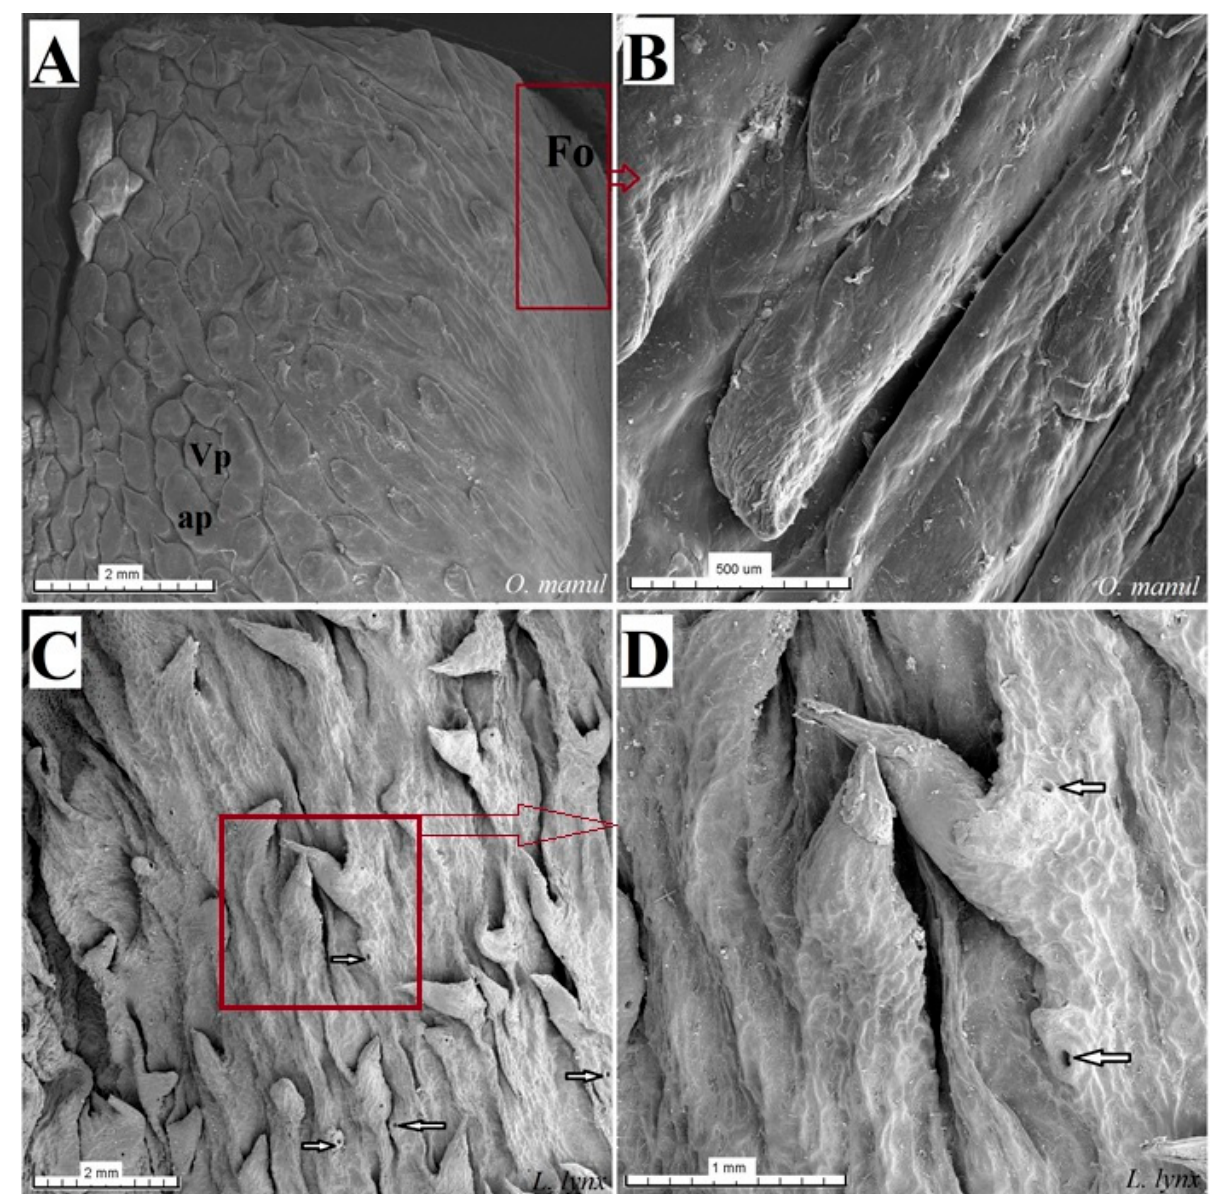
Figure 19. Scanning electron microscopy (SEM) pictures of the foliate papillae area of the tongue of O. manul ( A , B ) and lateral area of the tongue between the body and root of the L. lynx ( C , D ). ( A ) Foliate papillae area on the right part of the sample (maroon rectangle) and vallate papillae surrounded by the annular pad. ( B ) Magnification of the folds and grooves which form the foliate papilla. ( C ) Several round openings (white arrows) of the glandular ducts of posterior lingual glands on the lateral posterior surface of the tongue and several well-visible conical papillae. ( D ) Magnification of the opening of the lingual gland ducts and two conical lingual papillae. Bar = 2 mm (A,C); bar = 1 mm (D); bar = 500 µm (B). Abbreviations: ap—annular pad, Fo—foliate papilla, Vp—vallate